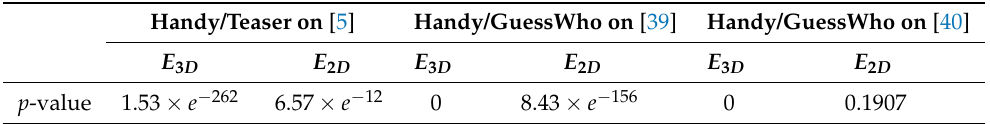
Table 3. The results of significance tests on the E 3 D and E 2 D for the Handy data-set.